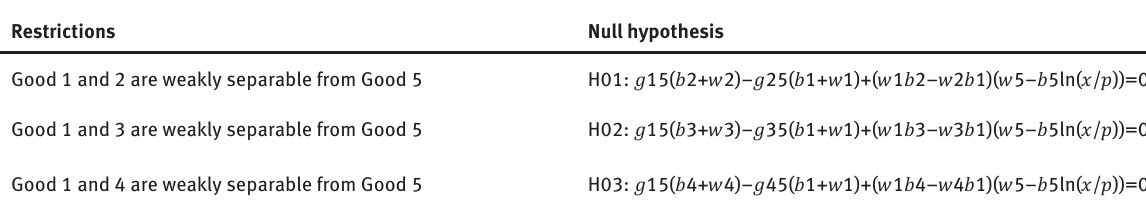
Table 2: Null hypothesis with respective restrictions for testing separability